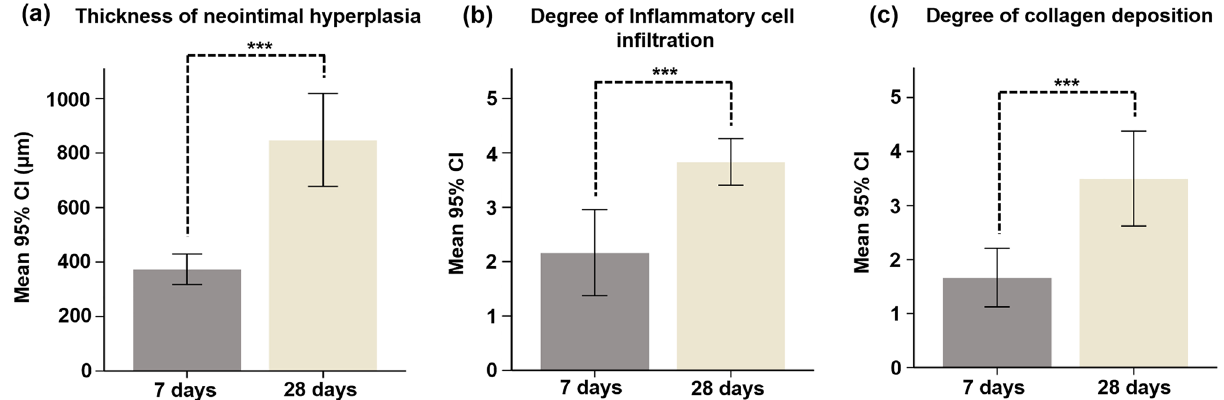
Figure 5. Histological findings. ( a – c ) Histological results of the LIA on days 7 and 28. CI, confidence interval; *** p <